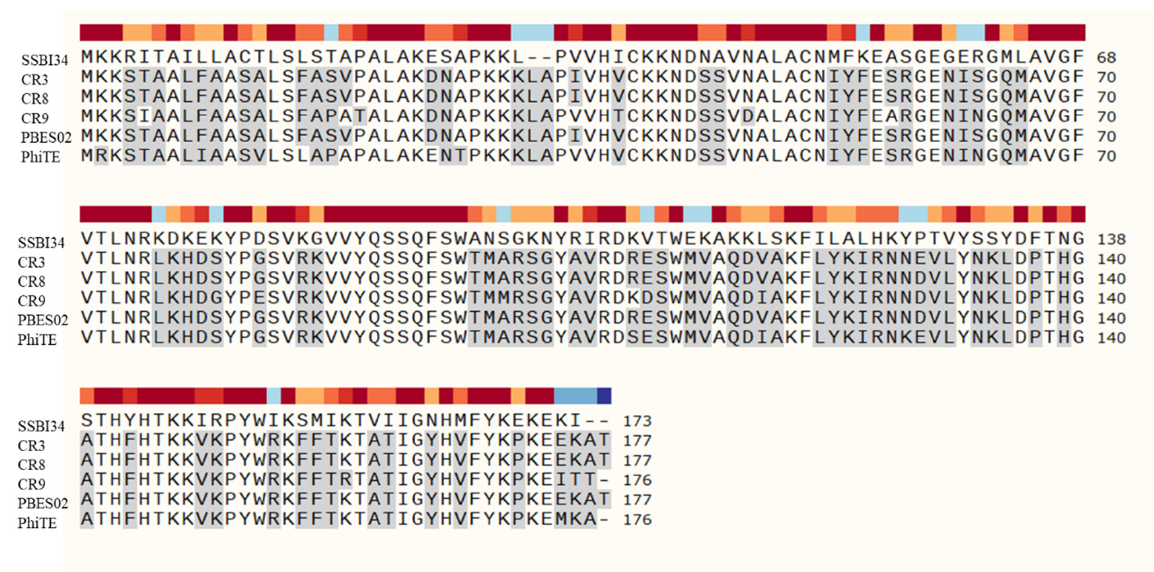
Figure 5. Amino acid sequence comparison of hydrolases in Vequintavirinae using SnapGene software version 5.3. SSBI34 has no nucleotide homology in BLASTn, whereas only 50% amino acid sequence homology was observed with other hydrolases. The hydrolases from other members of Vequintavirinae show high homology with each other. All amino acid residues in other phages that are different from SSBI34 amino acid residues are highlighted in grey.